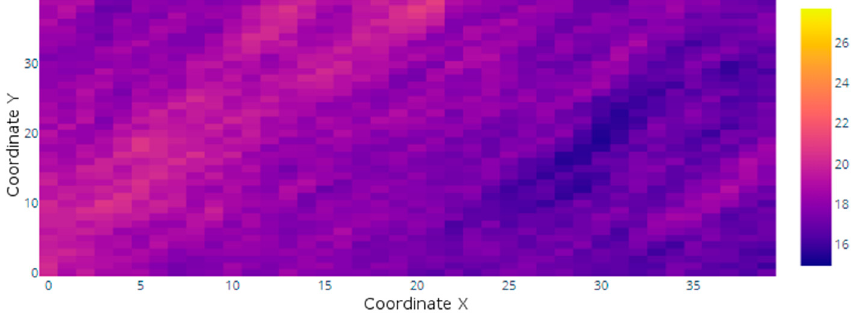
Figure 3. Sample heat map.